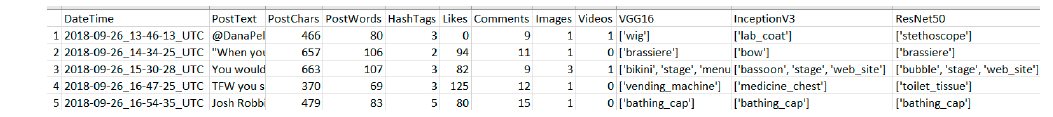
Figure 3. jnj account posts metadata.